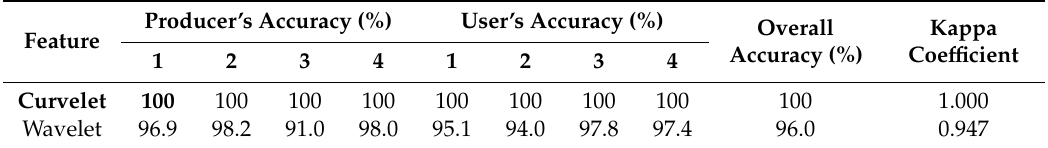
Table 2. Quantitative evaluation of a simulated SAR